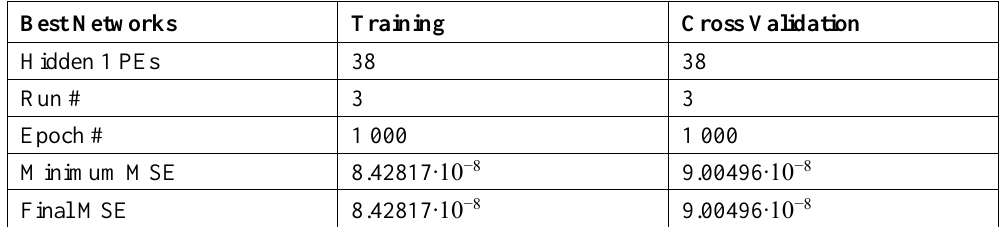
Table 4. Training and cross-validation process (developed by the author) Best